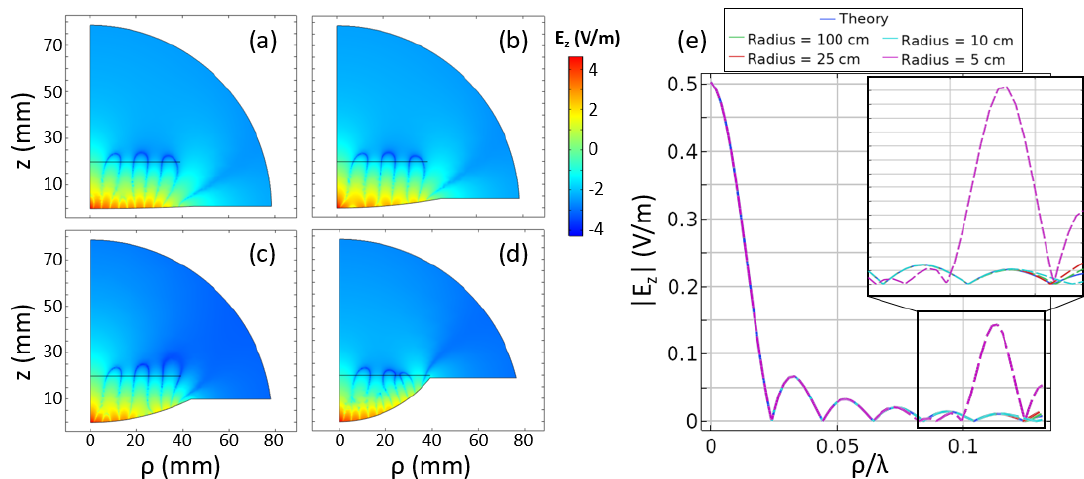
Figure 9. ( a – d ) The geometry and electric field for various radii, including 100 cm, 25 cm, 10 cm, and 5 cm, respectively. ( e ) The electric field in the focal plane, which generally exhibits a good match between the desired theory and the achieved pattern. Notable deviation is seen in the case of the 5-cm radius because of the close proximity between the focal plane and the designed surface.